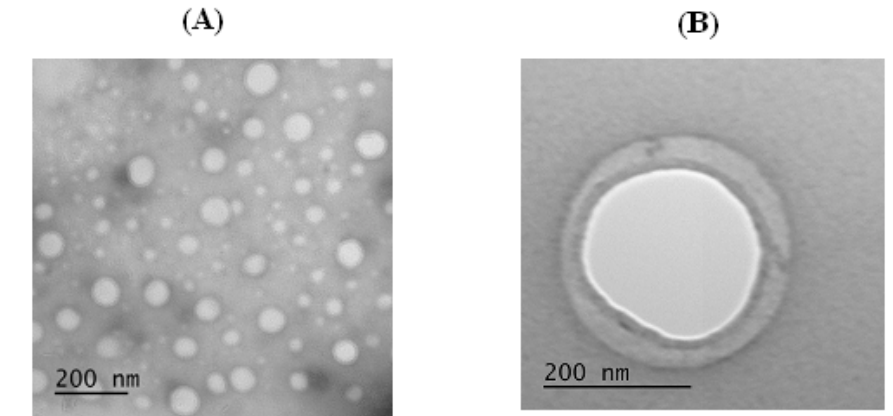
Figure 7. TEM images of polymer nanoparticles obtained (pH 8.4, concentration 0.5 mg/mL). ( A ) Polymersomes (GP2); and ( B ) single polymersome (GP3).